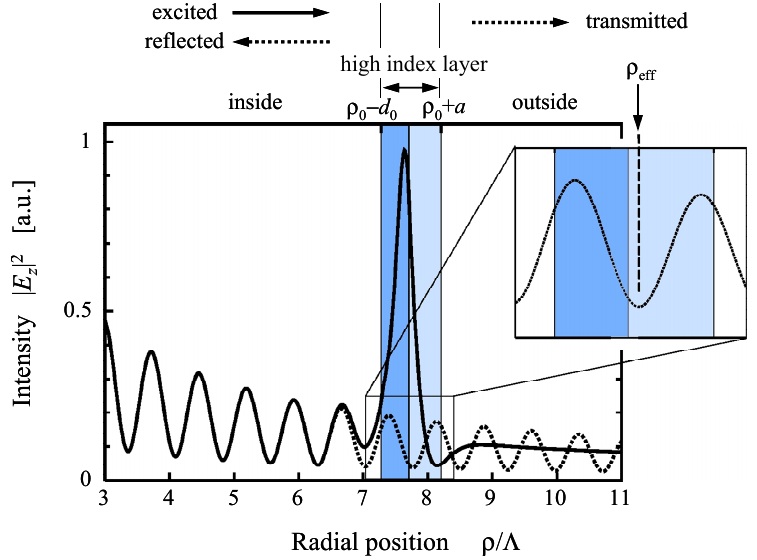
Figure 5. Example of a calculated field intensity profile upon reflection (solid line) and its extrapolated curve (dotted line), for the m = 50 structure. The latter is a linear summation of